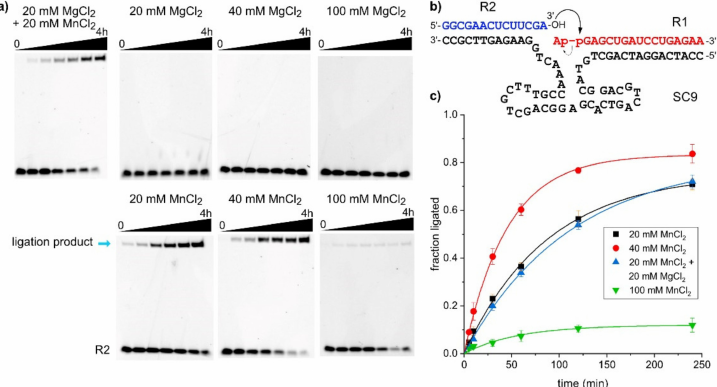
Figure 3. Metal ion requirement of SC9. ( a ) PAGE images of kinetic experiments under di ff erent metal ion conditions. ( b ) Predicted secondary structure scheme of RNA substrates hybridized to SC9 deoxyribozyme used in these experiments. ( c ) Yield versus time data from three independent experiments, represented as mean ± stdev and fitted to pseudo-first order kinetics. k obs values are 0.012 (20 mM Mn 2 + ), 0.022 (40 mM Mn 2 + ), 0.009 (20 mM Mn 2 + + 20 mM Mg 2 + ); final yield is only 12% for 100 mM Mn 2 +